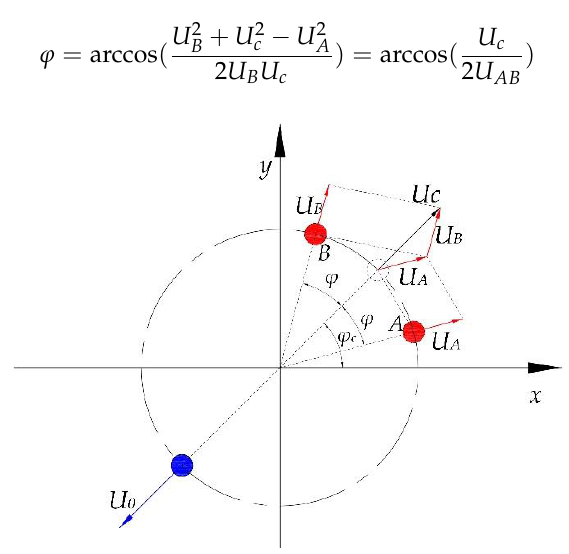
Figure 11. Control principle of the active balancing system.